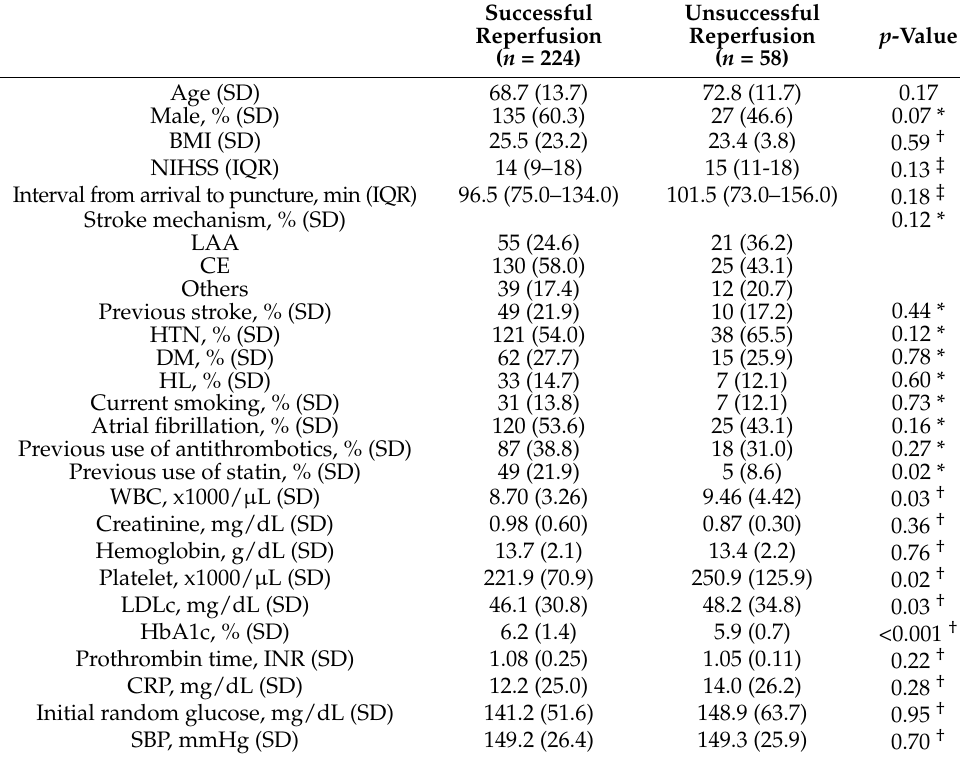
Table 1. Baseline characteristics according to reperfusion